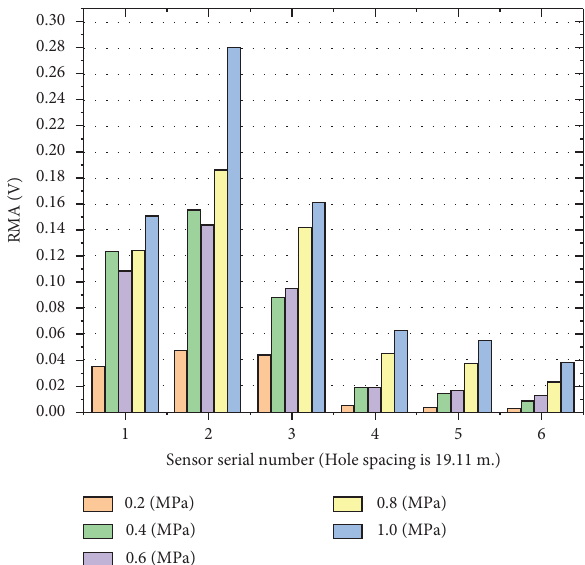
m.)3 Sensor serial number (Hole spacing is 19.11 Figure 8: Variation of the leakage acoustic signal RMS value of A and B leakage with the distance under diferent pressures.